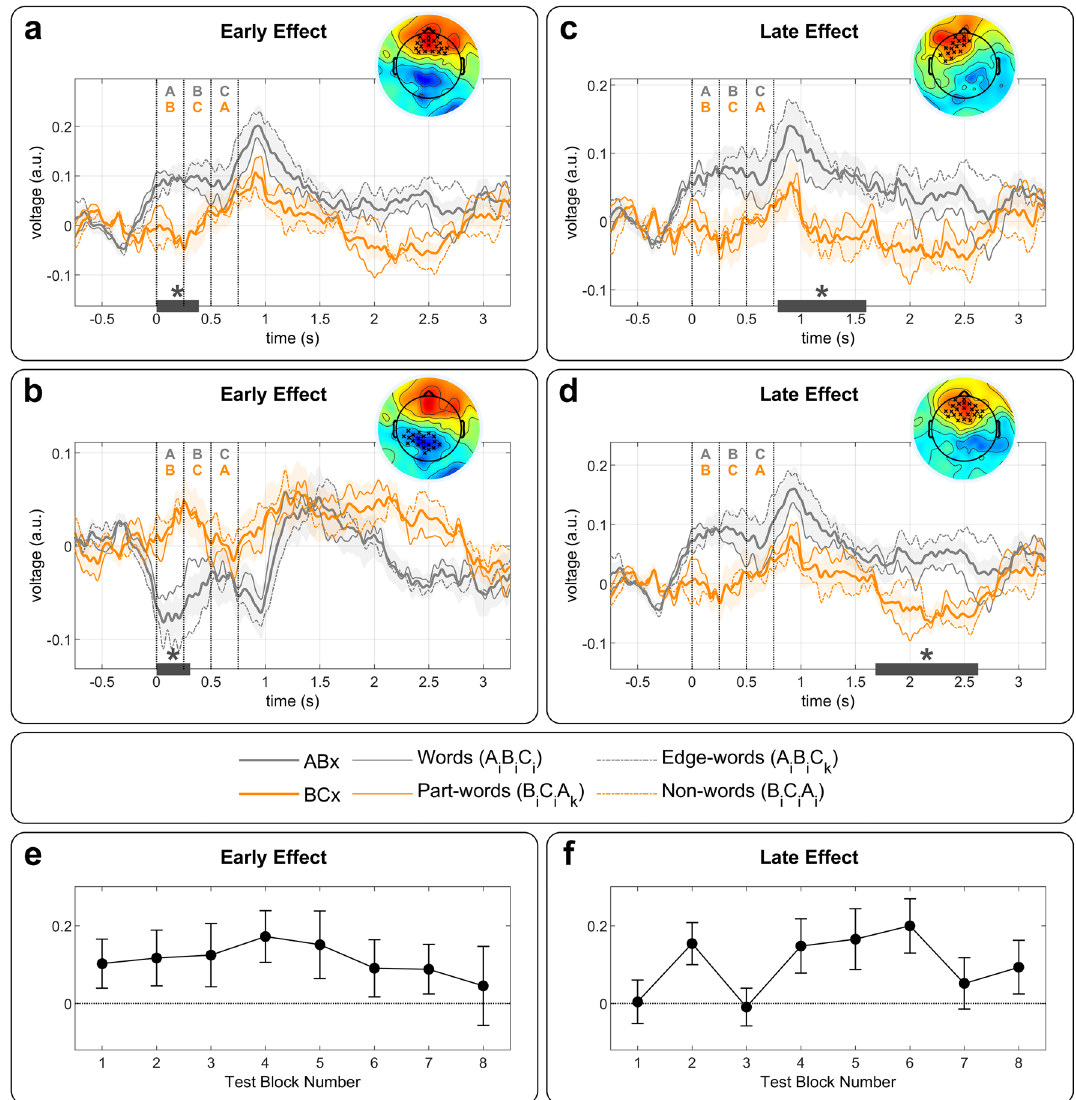
Figure 4. Responses to triplets in isolation. ( a ) Grand-average response to ABx and BCx triplets over the early frontal positive cluster ( p = 0.0152) obtained from the cluster-based permutation analysis. The thick lines correspond to ABx (gray line) and BCx (orange line) conditions and the thin lines to the sub-conditions (Words and Edge-Words vs. Part-words and Non-words). Shaded areas correspond to the standard error across neonates. The time zero corresponds to the onset of the test word. Vertical lines signal the onset of each syllable and the end of the word. The topography shows the difference ABx - BCx during the time window where significant differences were observed (gray line under the plot). ( b ) Same as ( a ), but for the early negative cluster over left-temporal posterior electrodes ( p = 0.0324). ( c ) Same as ( a ), but for a late positive cluster over frontal-left electrodes ( p = 0.0142). ( d ) Same as ( a ), but for a later positive cluster over frontal electrodes ( p = 0.0020). ( e ) Time progression of the ERP early effects ( a, and b ) over the 8 test blocks. ( f ) Time progression of the average of the two late ERP effects ( c , and d ) over the 8 test